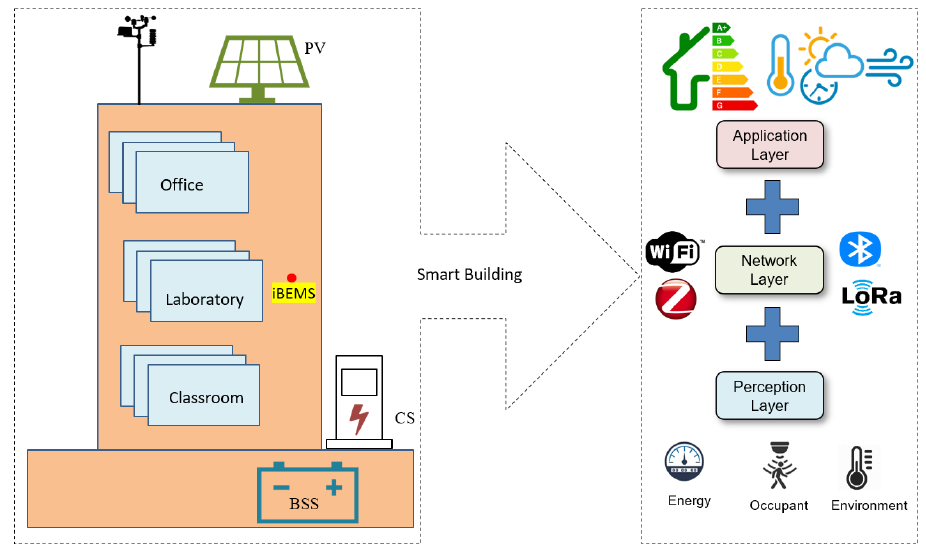
Figure 2. The schematic diagram for IoT-based architecture for smart buildings. iBEMS: intelligent building energy management system.